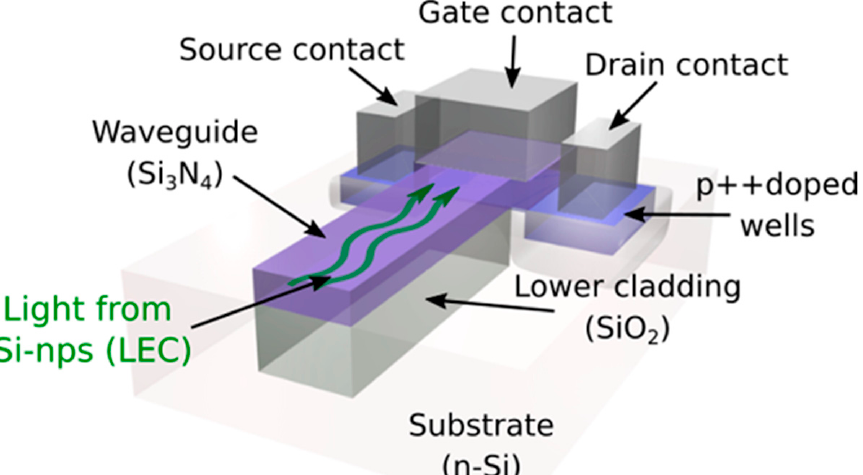
Figure 11. Concept of a transistor-like photodetector in which the Si 3 N 4 waveguide simultaneously